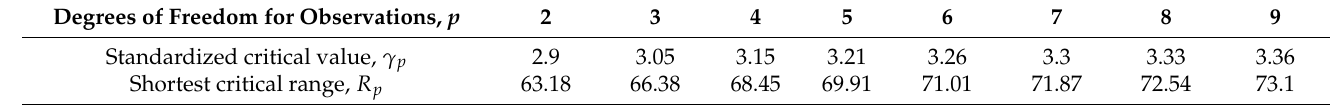
Table 4. Standardized critical values for functions γ p = γ ( p ) and R p = R ( p )